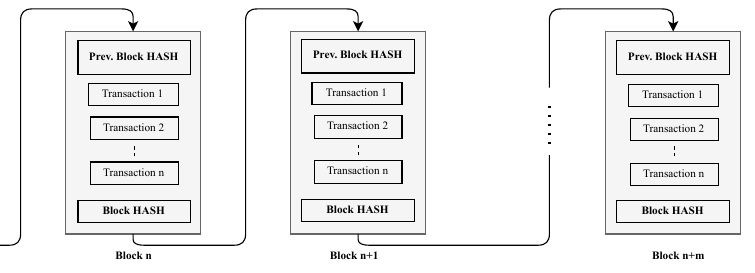
Figure 3. A blockchain